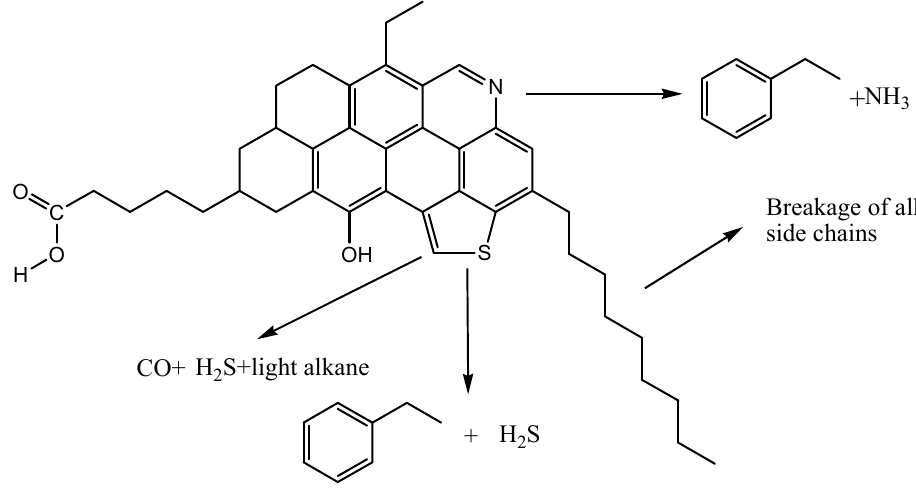
Figure 18. Chemical changes occurring in the aquathermolysis reaction of heavy oil.